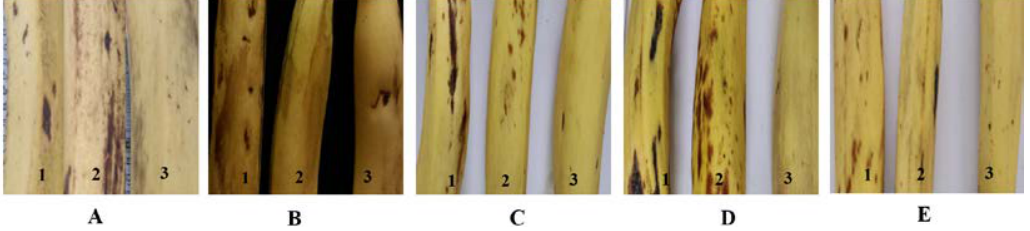
Fig. 3.3. 9 th day of banana sample treated with different treatment A. Sodium alginate B. Starch C. Aloe vera D. Gelatin E. Glycerol